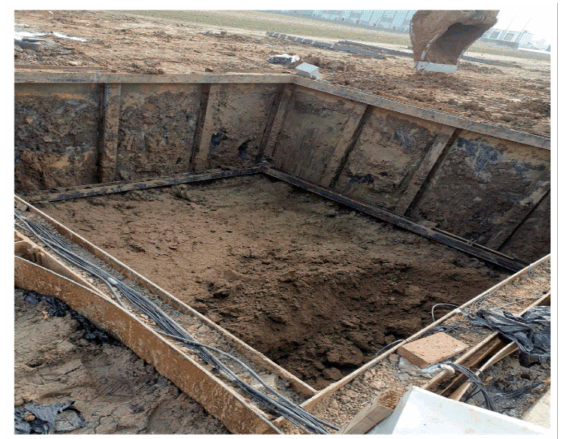
Figure 1. A schematic diagram of the field supporting